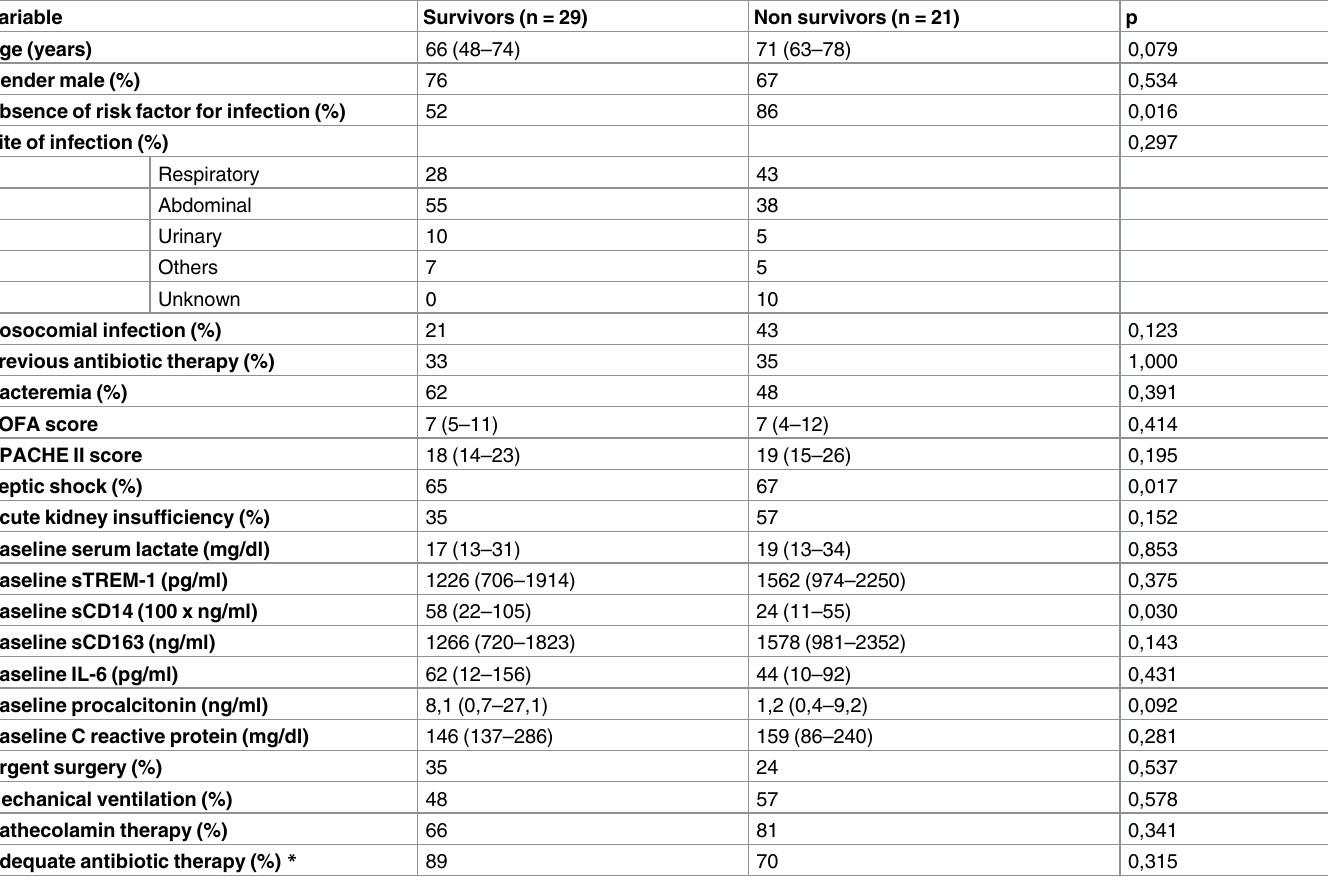
Table 7. Differential characteristics of patients who survive and those who died with severesepsis/septic shock.